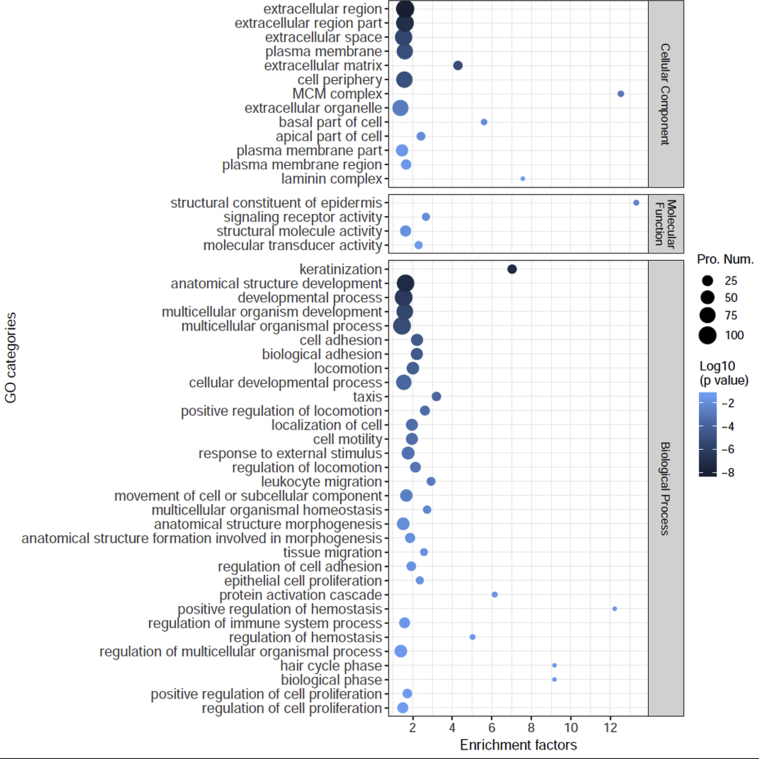
Enriched GO categories of up/down regulated proteins in well-differentiated normal human primary bronchial/tracheal epithelial cells compared with un-differentiated cells. Classification nodes that were 1 or 2 steps from the root node are shown. The size of the dot indicates the number of proteins in the up/down regulated protein set. P values were obtained by Fisher's test.